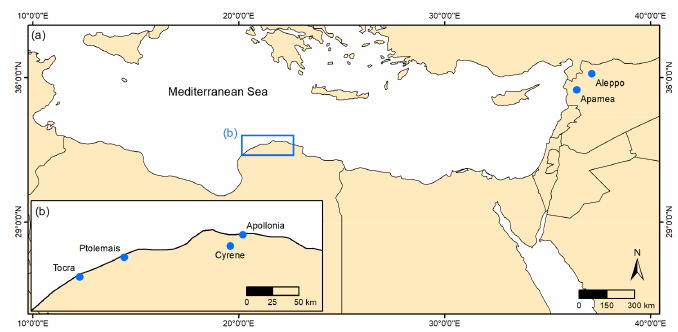
Figure 1. The geographic location of the heritage sites in the Mediterranean countries that represent the demonstration sites of this study (displayed on World Countries (Generalized), 2017